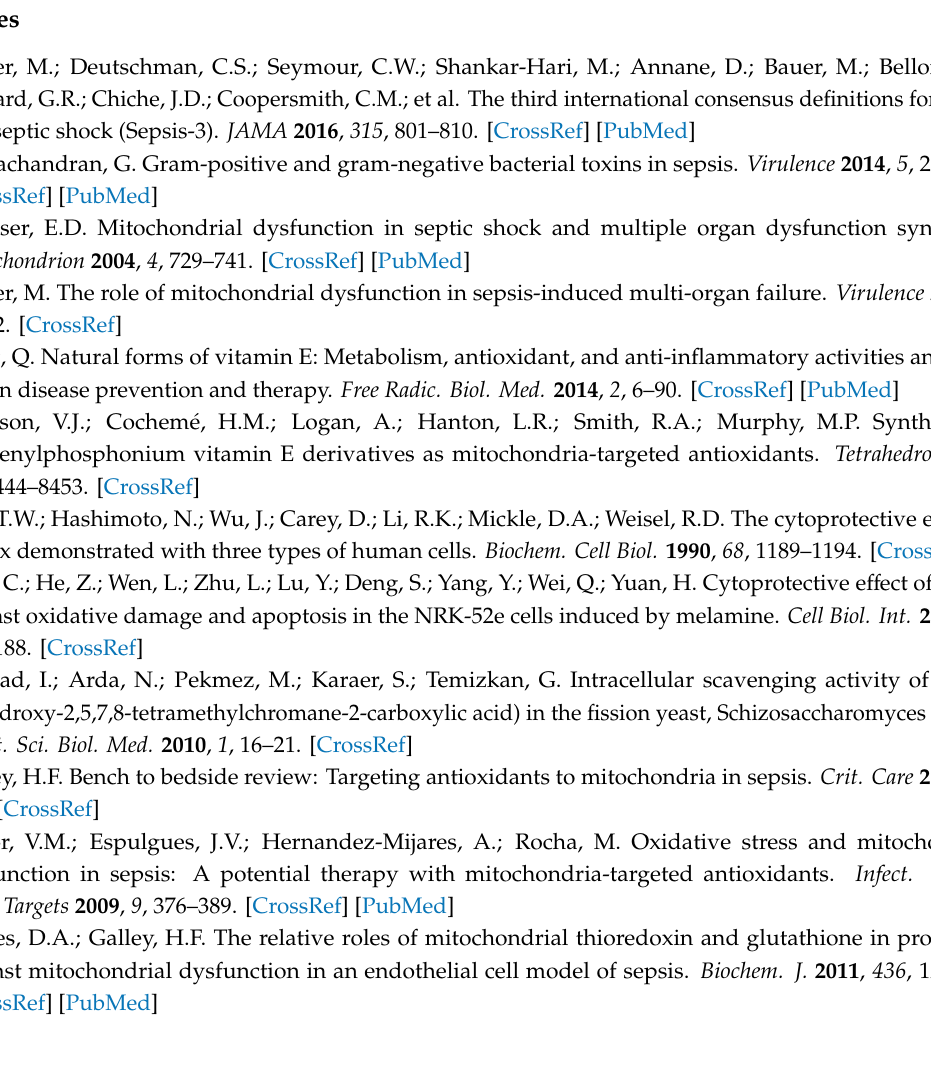
Figure S1: Microscopy images. Figure S2: Simplified Toll like receptor signaling pathway, Figure S3: Acid phosphatase activity, Figure S4: Western blot of nuclear NFkB P65 protein expression, Table S1: Gene ID and